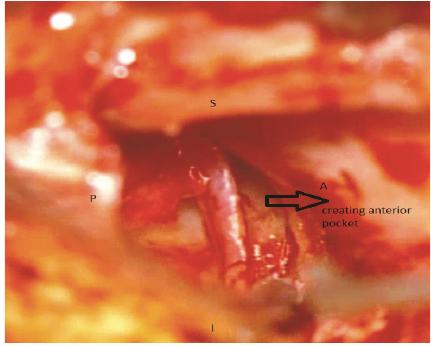
Figure 2: Elevation of the anterior tympanomeatal flap.